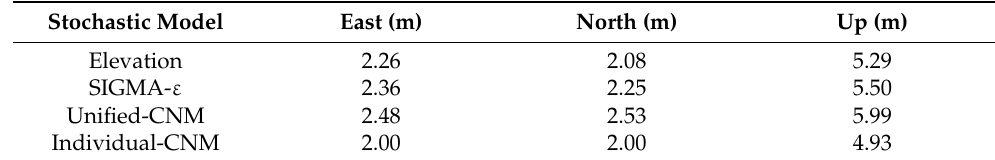
Table 3. Real-time differential root-mean-square (RMS) errors of different stochastic models for three directions.